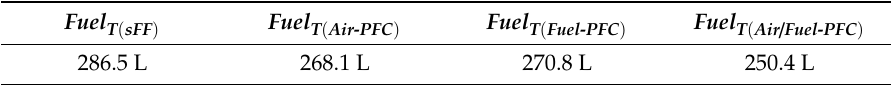
Table 1. Fuel consumption of the FC system using the strategies sFF, air-PFC, fuel-PFC, and air / fuel-PFC [34].